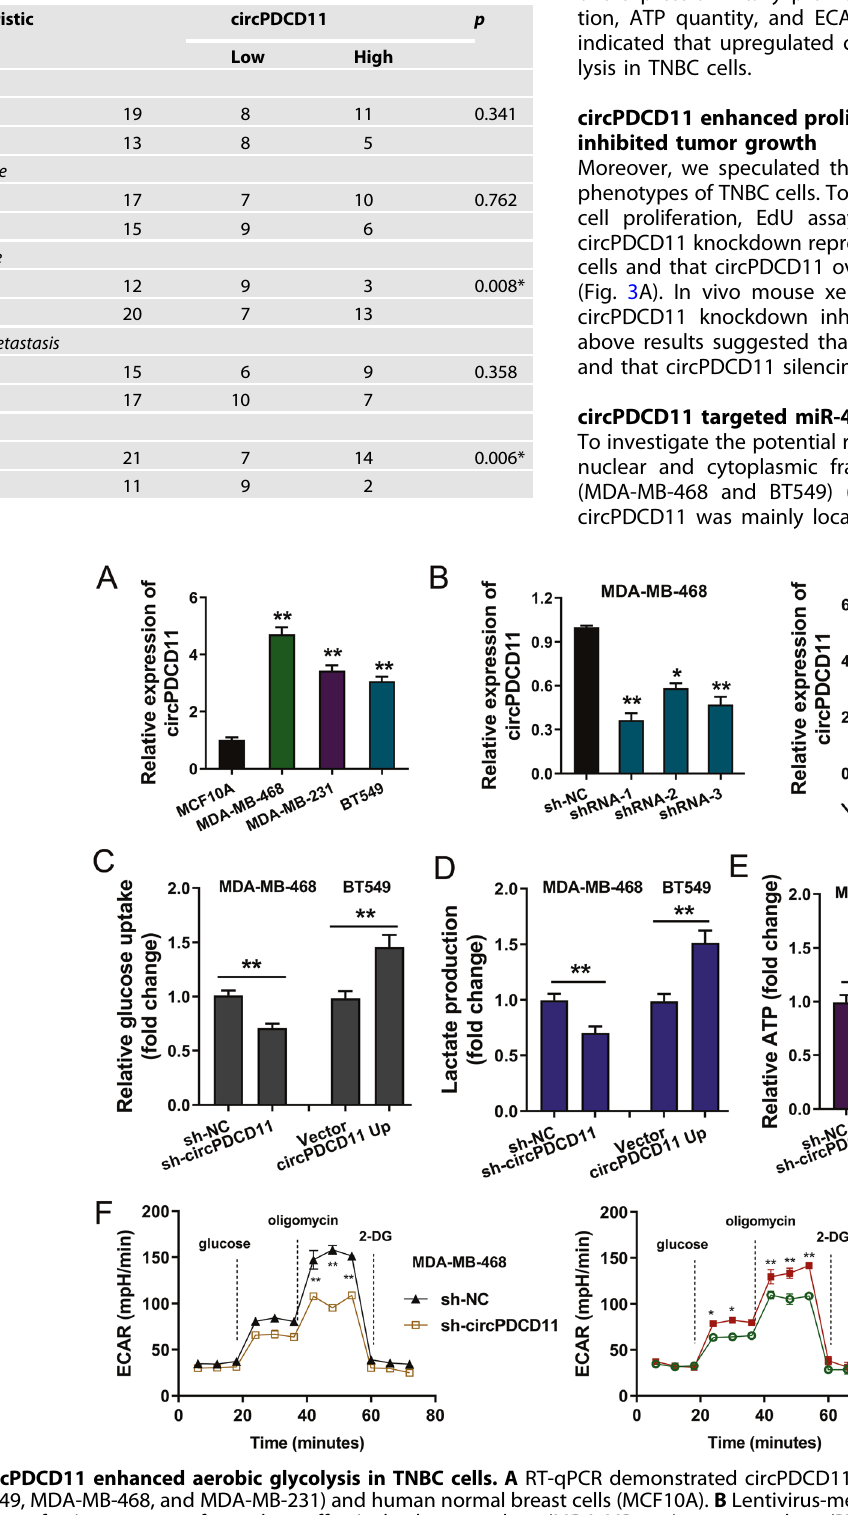
Table 1. Relationship between circPDCD11 and TNBC patients ’ clinicopathological characteristic.